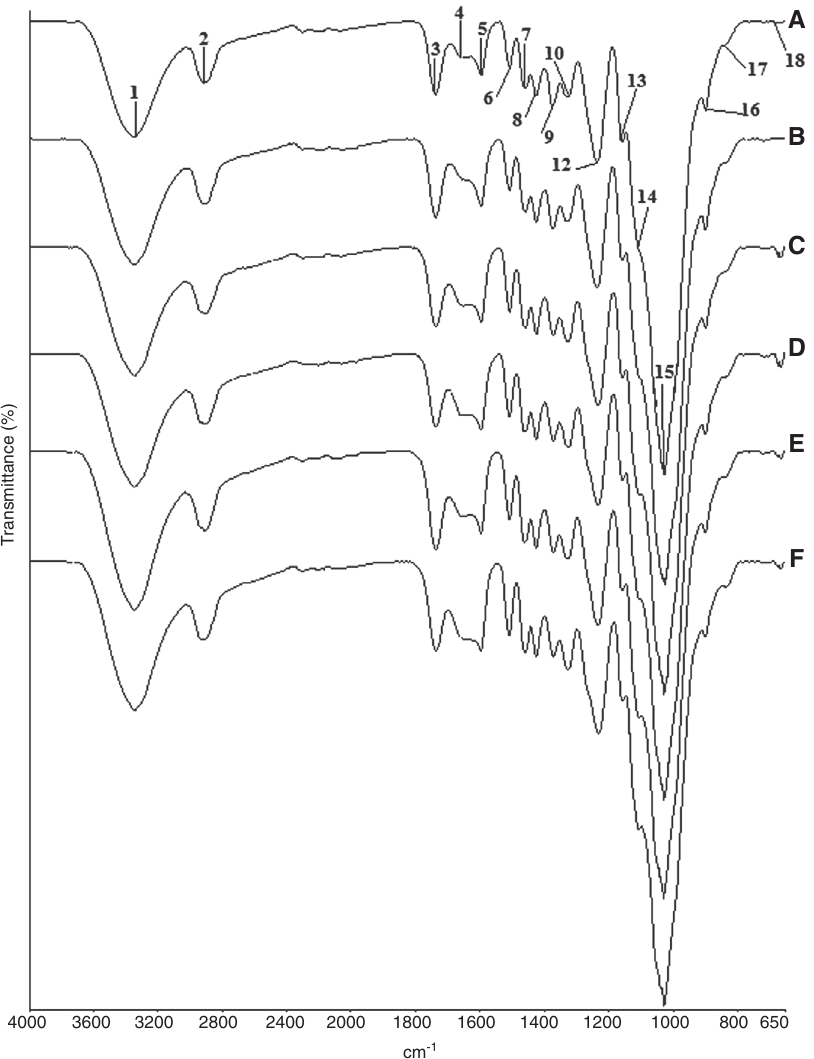
Figure 2 FT-IR spectral changes of beech samples: (A) unaged samples, (B) aged samples, (C) unaged samples degraded by C. puteana , (D) aged samples degraded by C. puteana , (E) unaged samples degraded by P. placenta , and (F) aged samples degraded by P. placenta